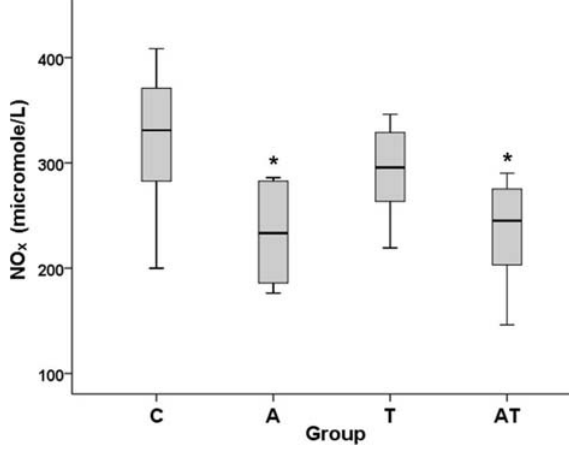
Figure 2. Effect of nandrolone decanoate (A), taurine (T) and their combination (AT) on plasma angiotensin converting enzyme (ACE) activity in rats. There was a signi fi cant increase of ACE activity in the A vs control (C) group and also vs the AT group (n=8 for each group). The box-and-whisker plots report the minimum, 25% percentile, median, 75% percentile, and maximum values. *P=0.004 vs C group; # P=0.04 vs AT group. (one-way ANOVA and Tukey ’ s post hoc analysis).